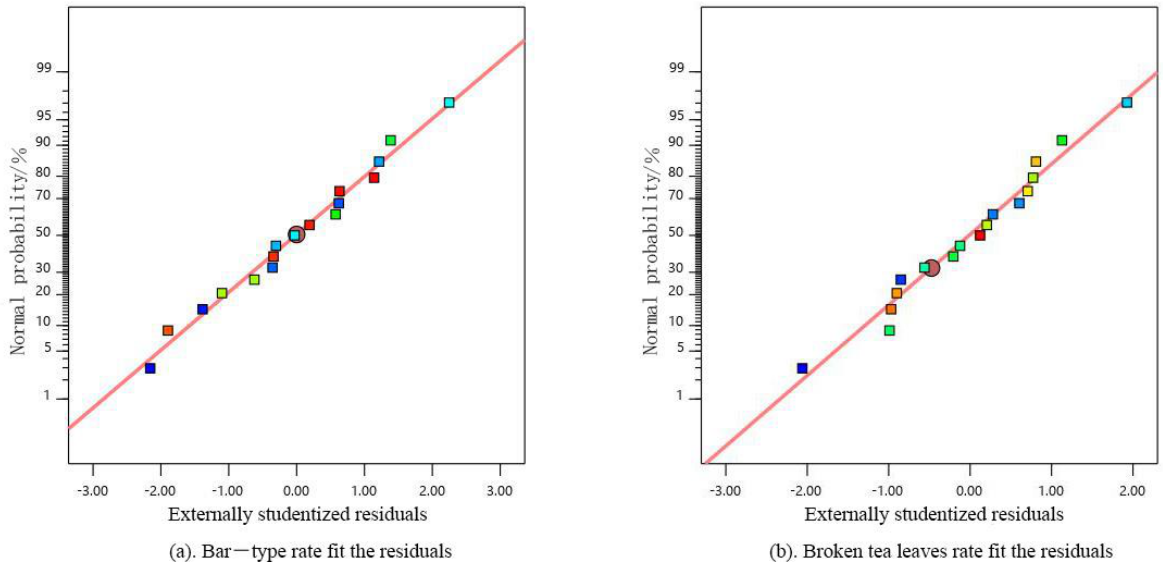
Figure 14. Fit the residuals of bar-type rate and broken tea leaf rate.